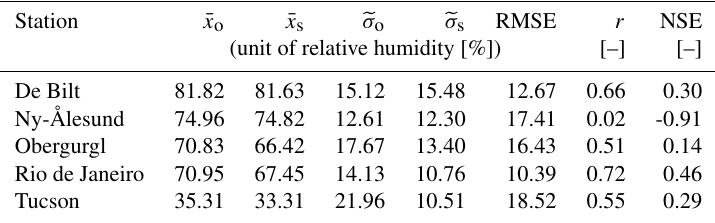
Table 4. Model performance measures for humidity disaggregation (H3 model). ¯ x o and ¯ x s are the mean values of observed and disaggregated relative humidity, respectively. The standard deviation of the observed ( e σ o ) and disaggregated ( e σ s ) time series are also specified. The root mean square error (RMSE), the correlation coefficient r , and the Nash–Sutcliffe model efficiency (NSE) are calculated using the observed and disaggregated time series for each